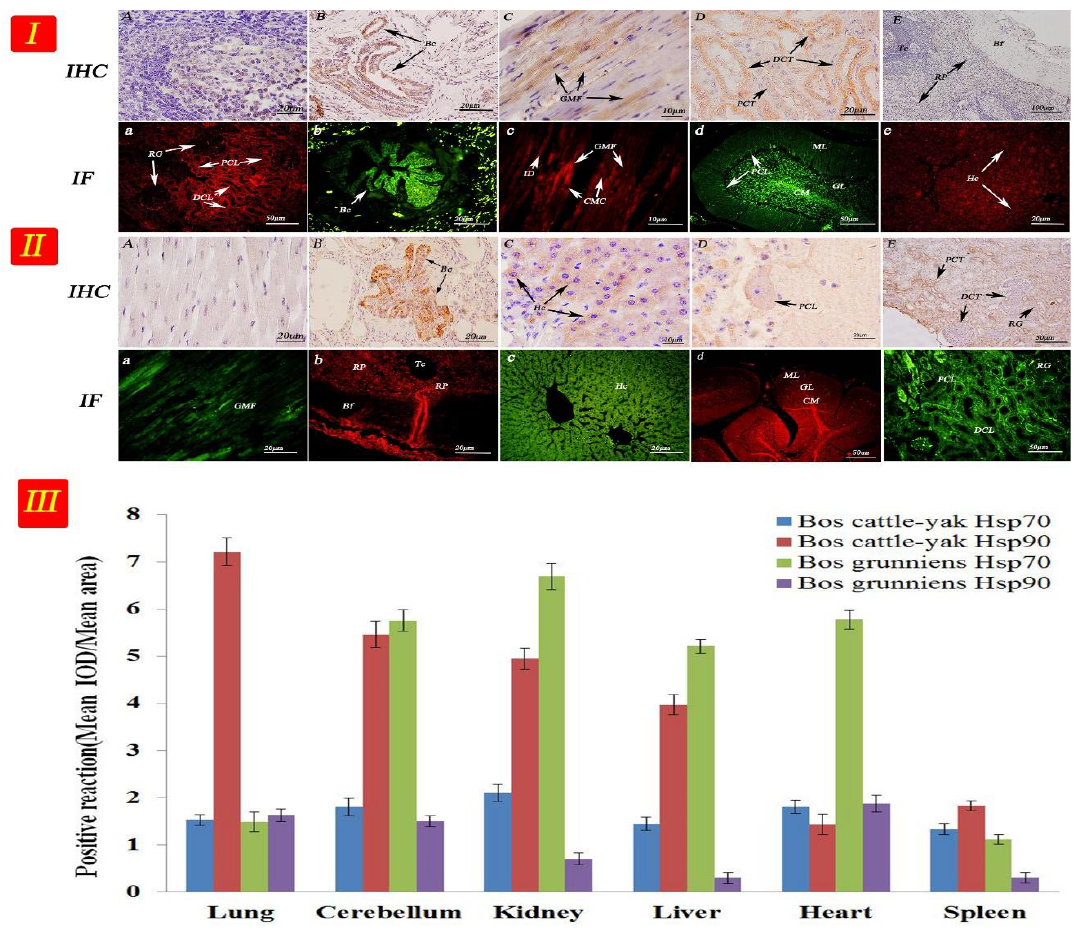
Figure 5. Hsp70 and Hsp90 expression of in diffrent tissues. The arrow represents the site of positive expression. IHC(A,B,C,D,E) and IF(a,b,c,d,e). ( I ) Cattle-yak: (A) Control section from yak spleen, without immunoreactions (negative control). (B), (D) Positive staining for Hsp90 was observed in the terminal bronchioles, distal convoluted tubule, and proximal convoluted tubule of lungs and kidney. (C), (E) Positive staining for Hsp70 was observed in the cardiac muscle fibers and red pulp of heart and spleen. (a), (c), (e) Positive staining for Hsp70 was observed in the distal convoluted tubule, proximal convoluted tubule, cardiac muscle fibers and hepatocytes in kidney, heart, and liver. (b), (d) Positive staining for Hsp90 was observed in the terminal bronchioles, cerebellar medulla, granular layer and Purkinje cell layer of lungs and cerebellum. ( II ) Yak: (A) Control section from yak heart, without immunoreactions (negative control). (B), (D) Positive staining for Hsp70 was observed in the terminal bronchioles, cerebellar medulla, granular layer and Purkinje cell layer of lungs and cerebellum. (C), (E) Positive staining for Hsp90 was observed in hepatocytes, distal convoluted tubule, and proximal convoluted tubule of liver and kidney. (a), (c), (e) Positive staining for Hsp90 was observed in the cardiac muscle fibers, hepatocytes, distal convoluted tubule, and proximal convoluted tubule of heart, liver, and kidney. (b), (d) Positive staining for Hsp70 was observed in the red pulp, cerebellar medulla, granular layer, and Purkinje cell layer of the spleen and cerebellum. Note: Terminal bronchiole (TB); hepatocyte (Hc); central vein (CV); cardiac muscle fibers (CMF); distal convoluted tubule (DCT); Purkinje cell layer (PCL); renal glomerulus (RG); biofilm (Bf); trabecula (Tc); red pulp (RP); white pulp (WP); cerebellar medulla (CM); molecular layer (ML); granular layer (GL); and proximal convoluted tubule (PCT). ( III ) The result of optical density analysis value. The curved lines represent expression trends of HSP proteins in different organs, and different color represents different proteins.